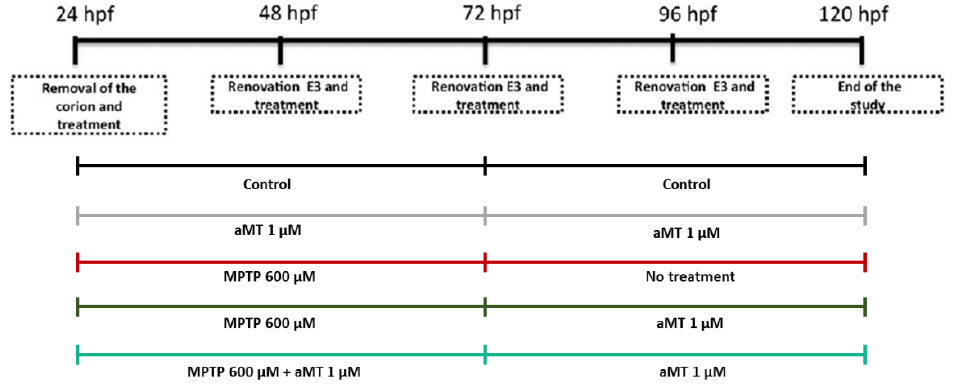
Figure 1. Schedule of the experimental conditions.